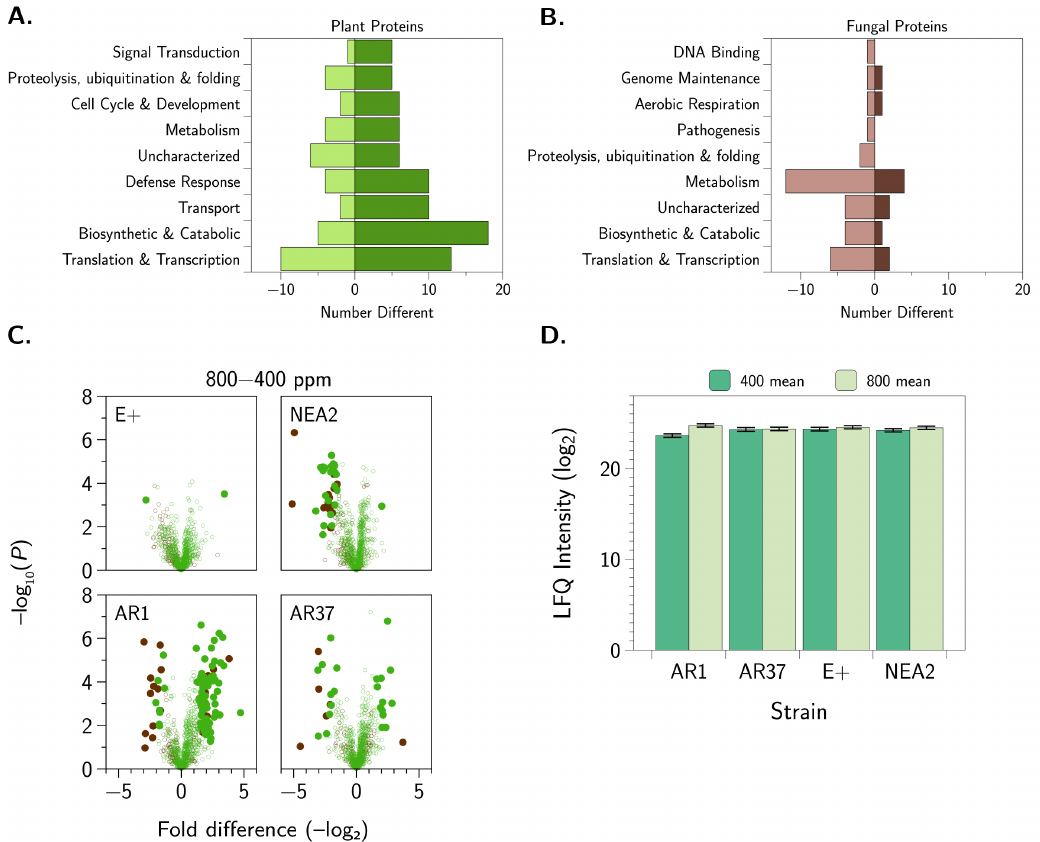
Figure 7. Quantitative proteomics profiling of CO 2 -mediated responses. ( A ) Distribution of differences in plant proteins based on Gene Ontology Biological processes displaying increased (dark green) or decreased (light green) abundance at 800 ppm CO 2 levels. ( B ) Distribution of differences in endophyte proteins based on Gene Ontology Biological processes displaying increased (dark red) or decreased (light red) abundance at 800 ppm CO 2 levels. ( C ) Volcano plots of L. perenne colonized with each epichloid strain at 800 vs. 400 ppm of CO 2 . Plant proteins that differed (Student’s t -test, p < 0.05, FDR = 0.05, S 0 = 1) between the CO 2 conditions are denoted with solid green symbols and fungal proteins that differed are denoted with solid brown symbols. Negative fold differences denote proteins that declined in abundance under elevated CO 2 , positive fold differences denote proteins that increased in abundance under elevated CO 2 . ( D ) LFQ intensity plot (mean ± standard error) of defense-related differences in plant proteins for L. perenne colonized with each epichloid strain ( N = 5). Quantification of five biological replicates. Error bars represent standard error of the